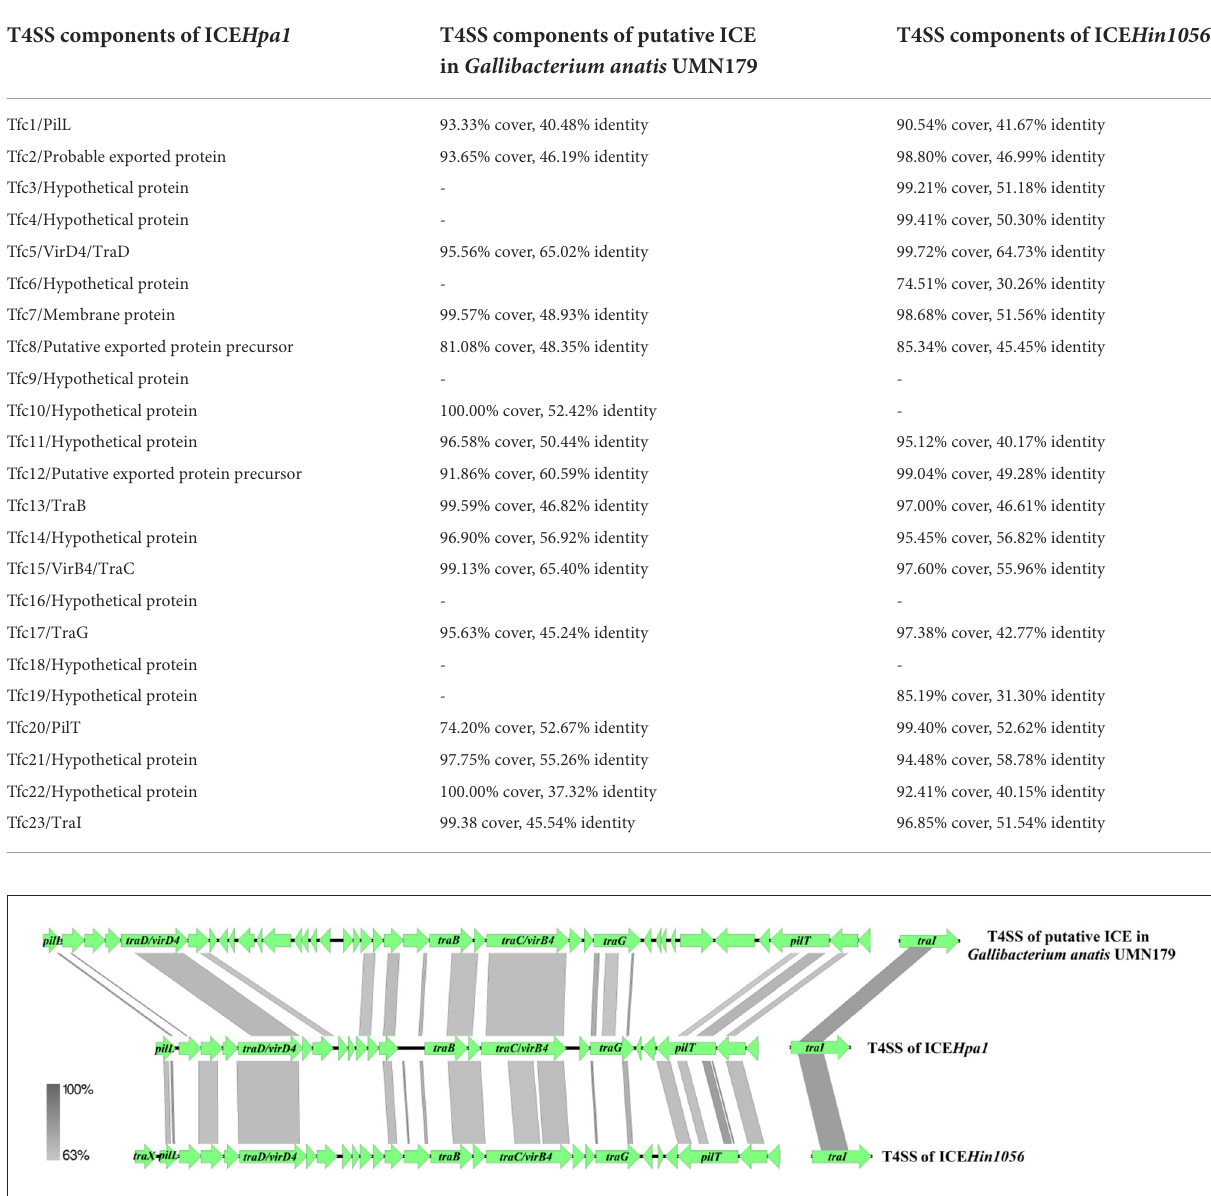
FIGURE2 Compared the T4SS of ICE Hpa1 (CP054198) with putative ICE in Gallibacterium anatis UMN179 (CP002667) and ICE Hin1056 (AJ627386). Regions of > 63% homology are marked by gray